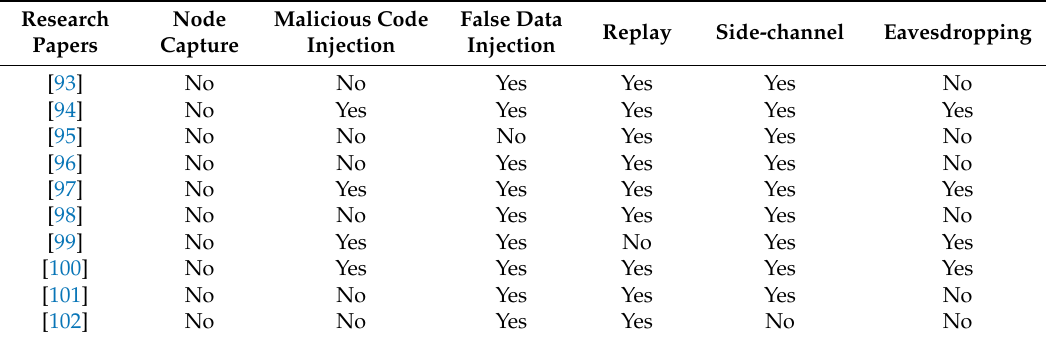
Table 8. Attacks on symmetric based encryption schemes.